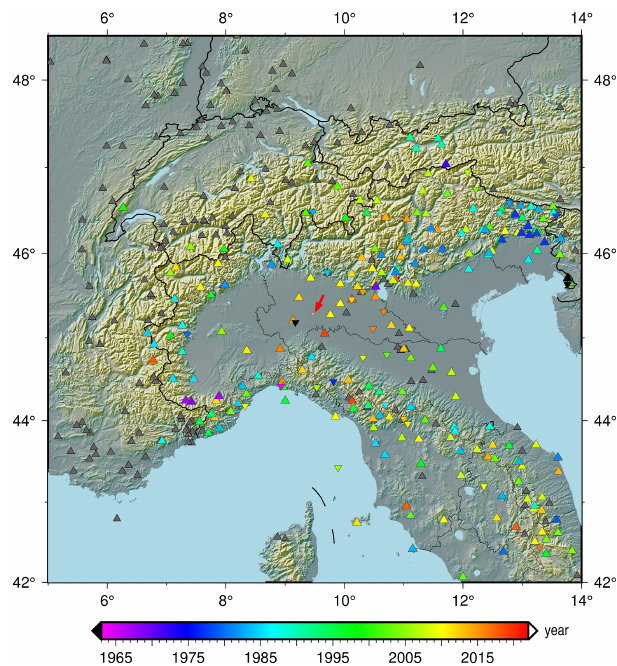
Figure 6. Location map of seismic stations used for the reloca- tions done in this study. The red arrow shows the location of the Cornegliano Laudense UGS. Stations are coloured according to the starting date, if known. Grey triangles are for unknown installation date, point-down triangles for stations that are no longer operative. Note that the stations mapped do not represent all the existing sta- tions, but only the ones for which phase readings have been col- lected in this